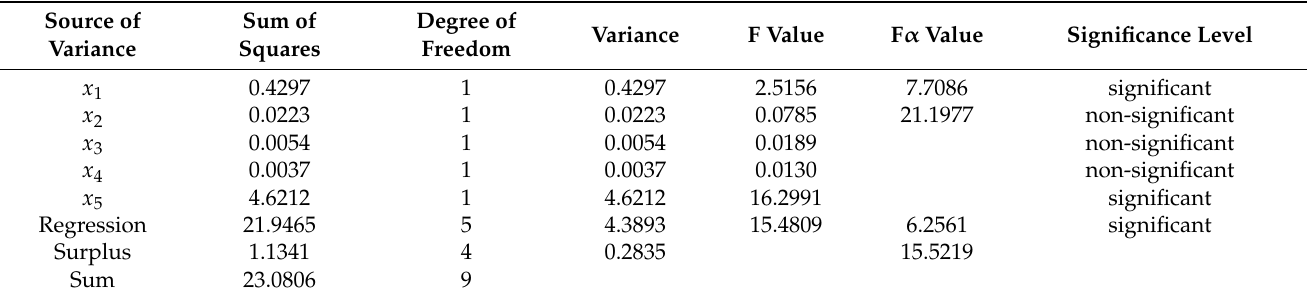
Table 6. Variance analysis results of the influence of various factors on the film lifting force after soil